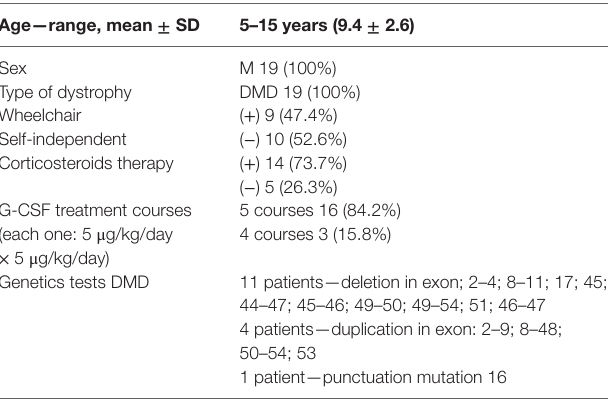
TablE 1 | Characteristics of the study population. age—range, mean ±